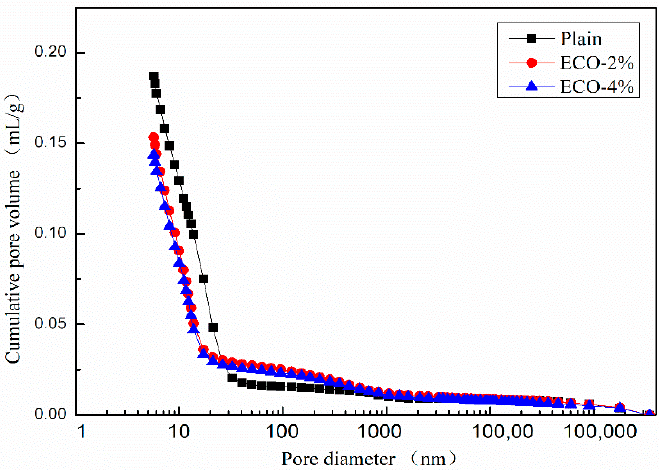
Figure 9. Cumulative pore size distribution.